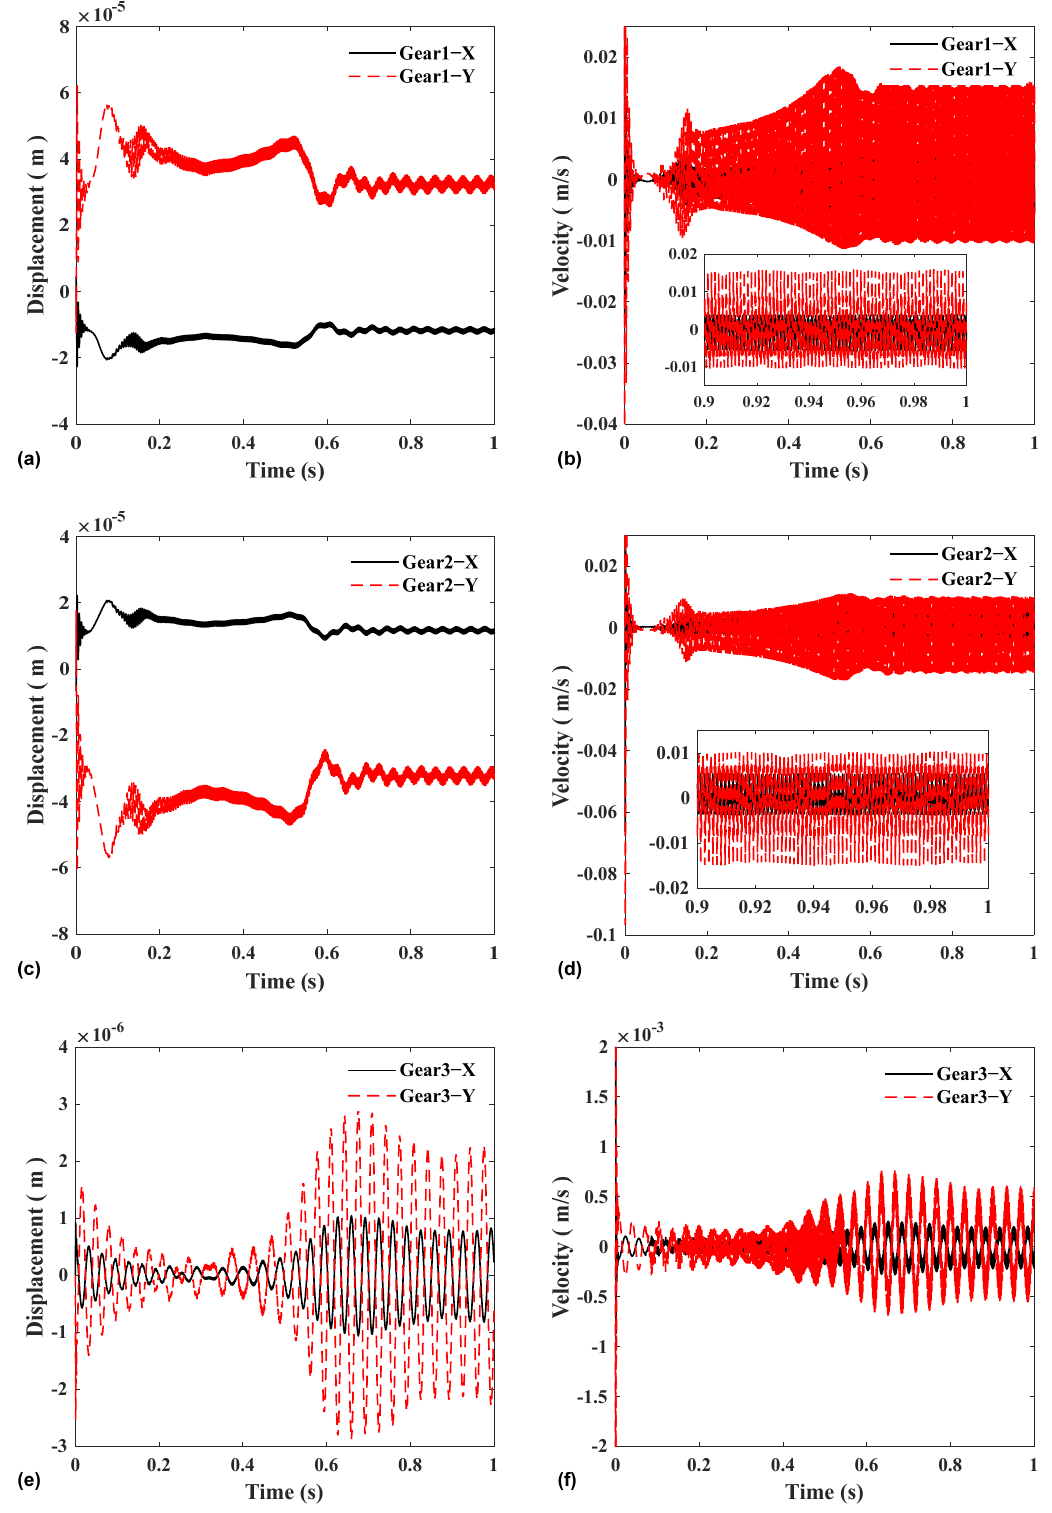
Figure 11. Horizontal and vertical displacement and vibration velocity of three gear: ( a ) gear 1 displacement; ( b ) gear 1 vibration velocity; ( c ) gear 2 displacement; ( d ) gear 2 vibration velocity; ( e ) gear 3 displacement; and ( f ) gear 3 vibration velocity.